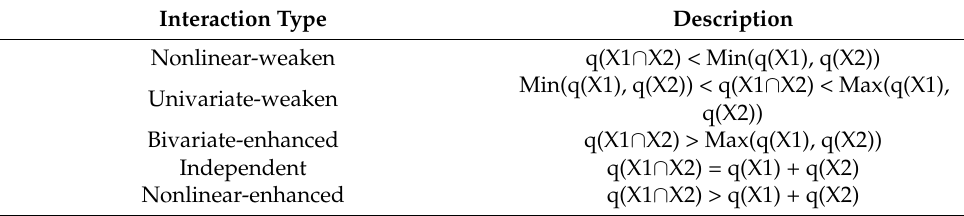
Table 3. Types of interaction between two explanatory variables (X1 and